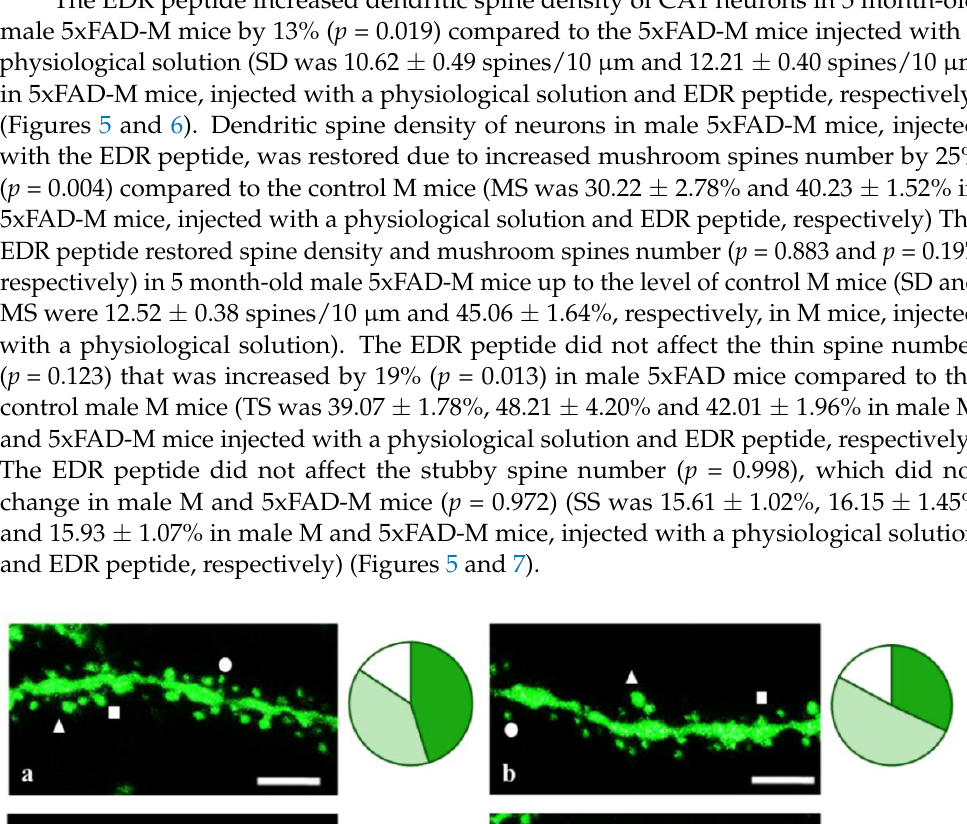
Figure 6. Spine density of CA1 secondary dendrites in 5 month-old male M-line and 5xFAD-M mice, injected with physiological solution, EDR peptide, KED peptide. *, **, ***— p < 0.05, p < 0.01, p < 0.001 compared to the 5xFAD-M mice injected with physiological solution, ns—non-significant.